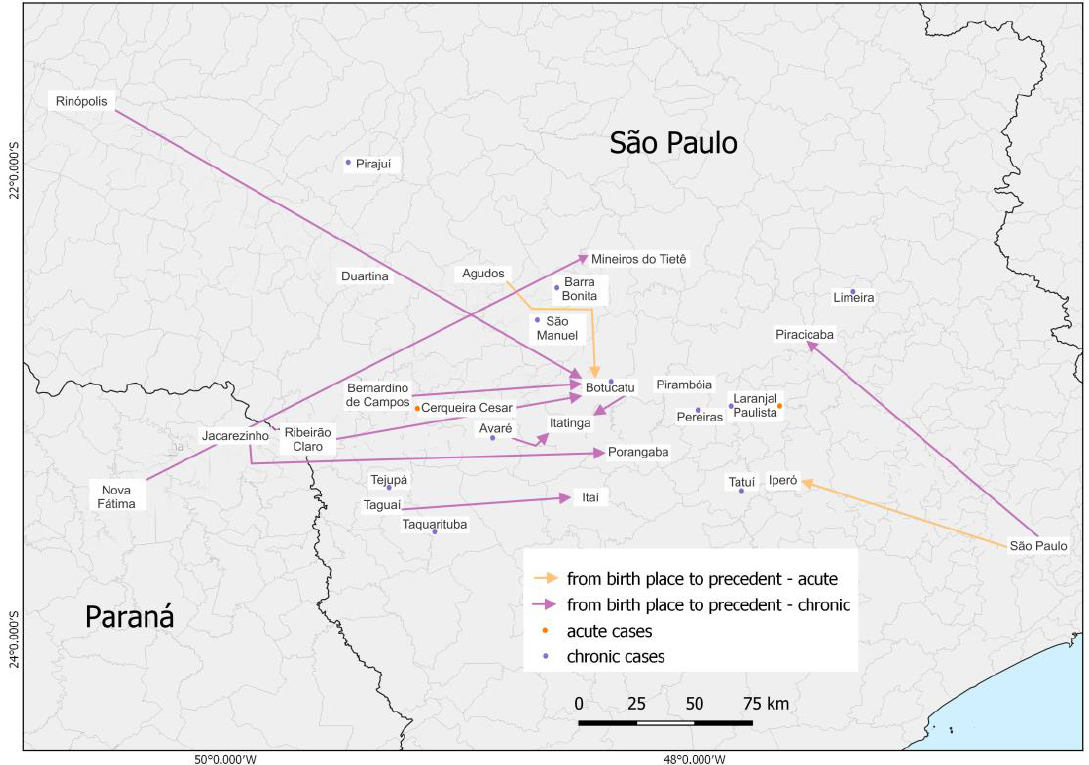
Figure 1. Map demonstrating the distribution of the 49 patients ’ birthplace, provenance, and clinical form (11 acute cases and 38 chronic